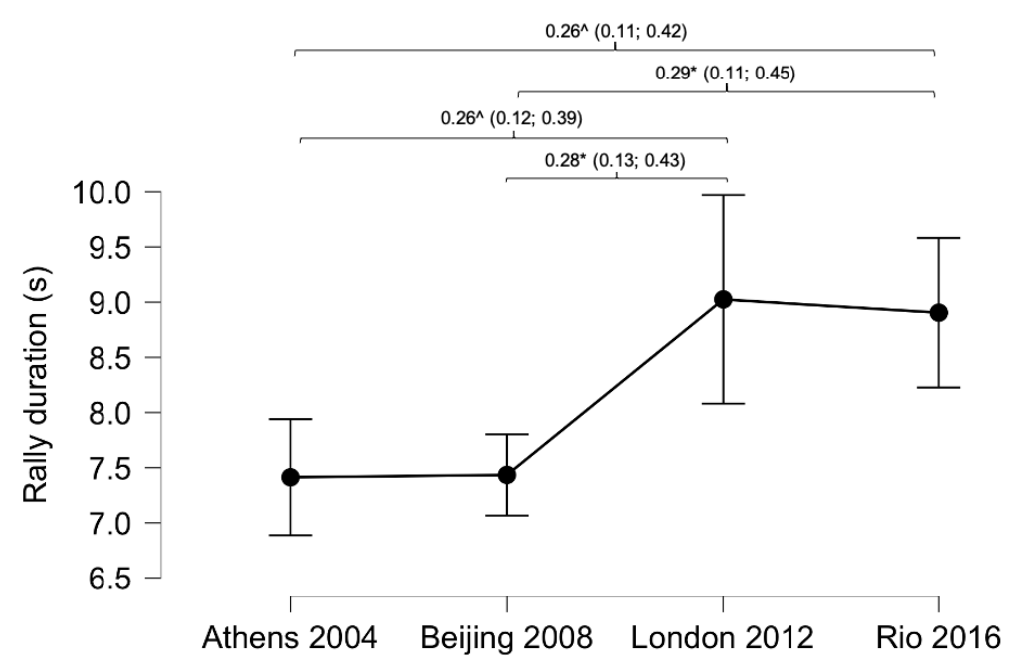
Figure 1. Differences in rally duration comparing Paralympic Games. Lines denote mean (95 CI). Effect sizes (±95% CI). * = p < 0.05; ^ = p < 0.01.